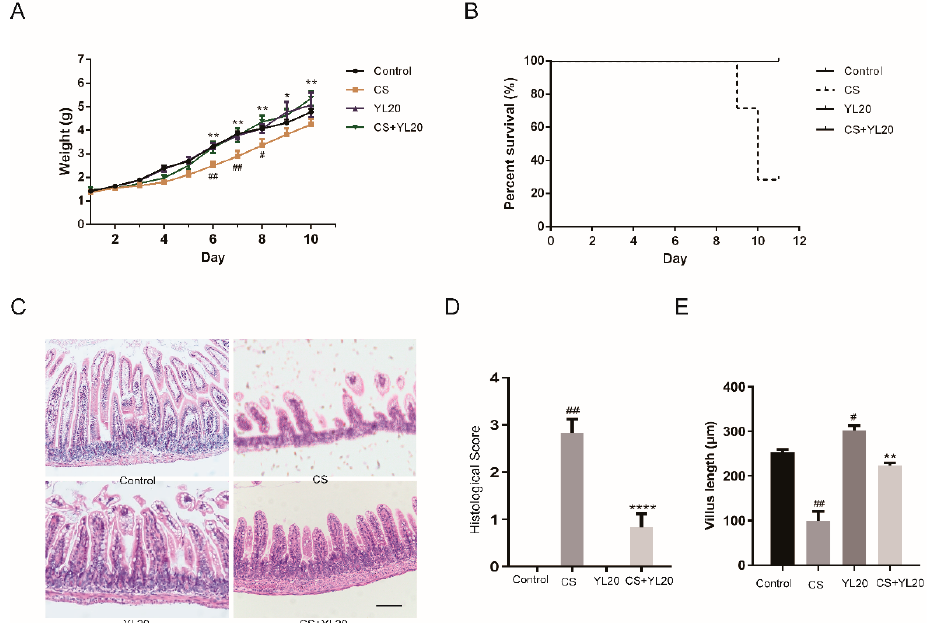
Figure 5. Effects of YL20 on C. sakazakii -induced clinical symptoms and intestinal epithelial damage in newborn mice. ( A ) Changes in body weight were monitored daily. ( B ) Mortality rate for neonatal mice in different groups during experiments. ( C ) Images of H&E-stained small intestinal sections from C. sakazakii -infected mice with or without YL20 administration; scale bar = 100 µ m. ( D ) Pathol- ogy/inflammation scores. ( E ) The length of villus was measured in at least 50 villi/mouse. # p <